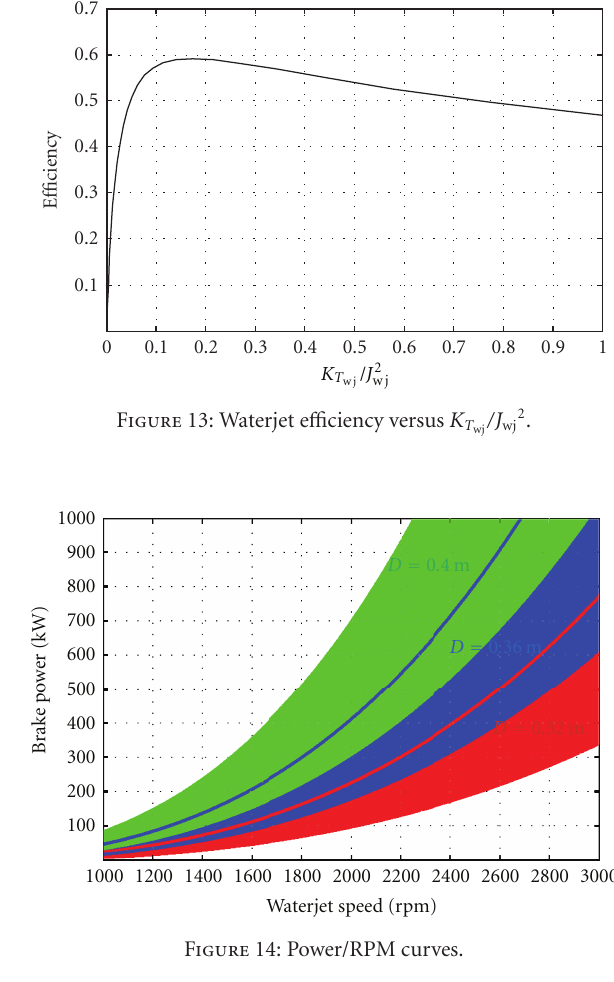
Figure 14: Power/RPM